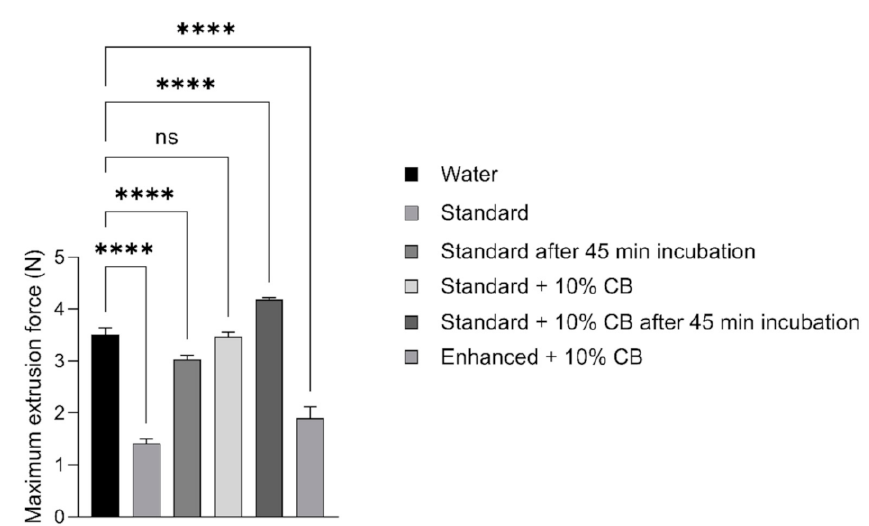
Figure 2. Injectability analysis of alginate-based hydrogels: Extrusion force needed to inject the hydrogels (SD and SD + 10% CB) into the artificial cerebrospinal fluid, using Hamilton syringe with 31G needle. The hydrogels were measured freshly prepared and after 45 min incubation in aCSF. Data presented as mean ( ± SD), n = 2. **** p < 0.0001, ns—not significant, compared to water.